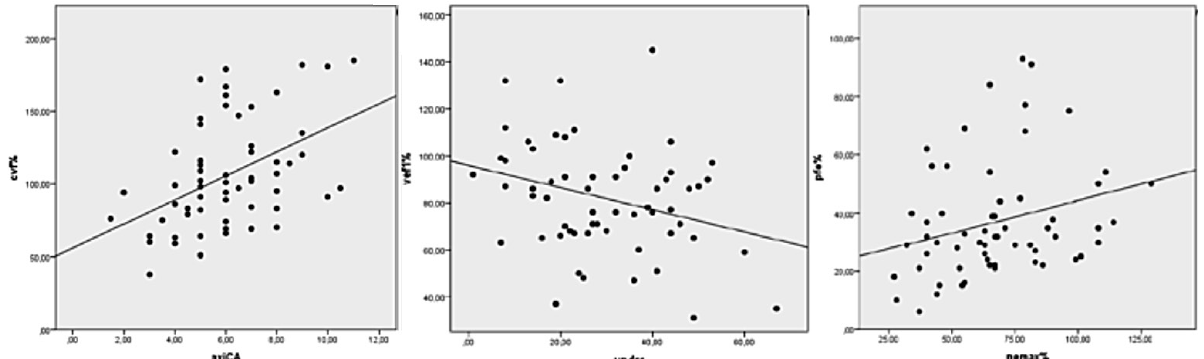
Figure 1 - Correlations between FVC % and Axillary level AC, FEV1 % and UPDRS, EFP % and MEP % of elderly with PD attended at CREASI in Salvador/BA,